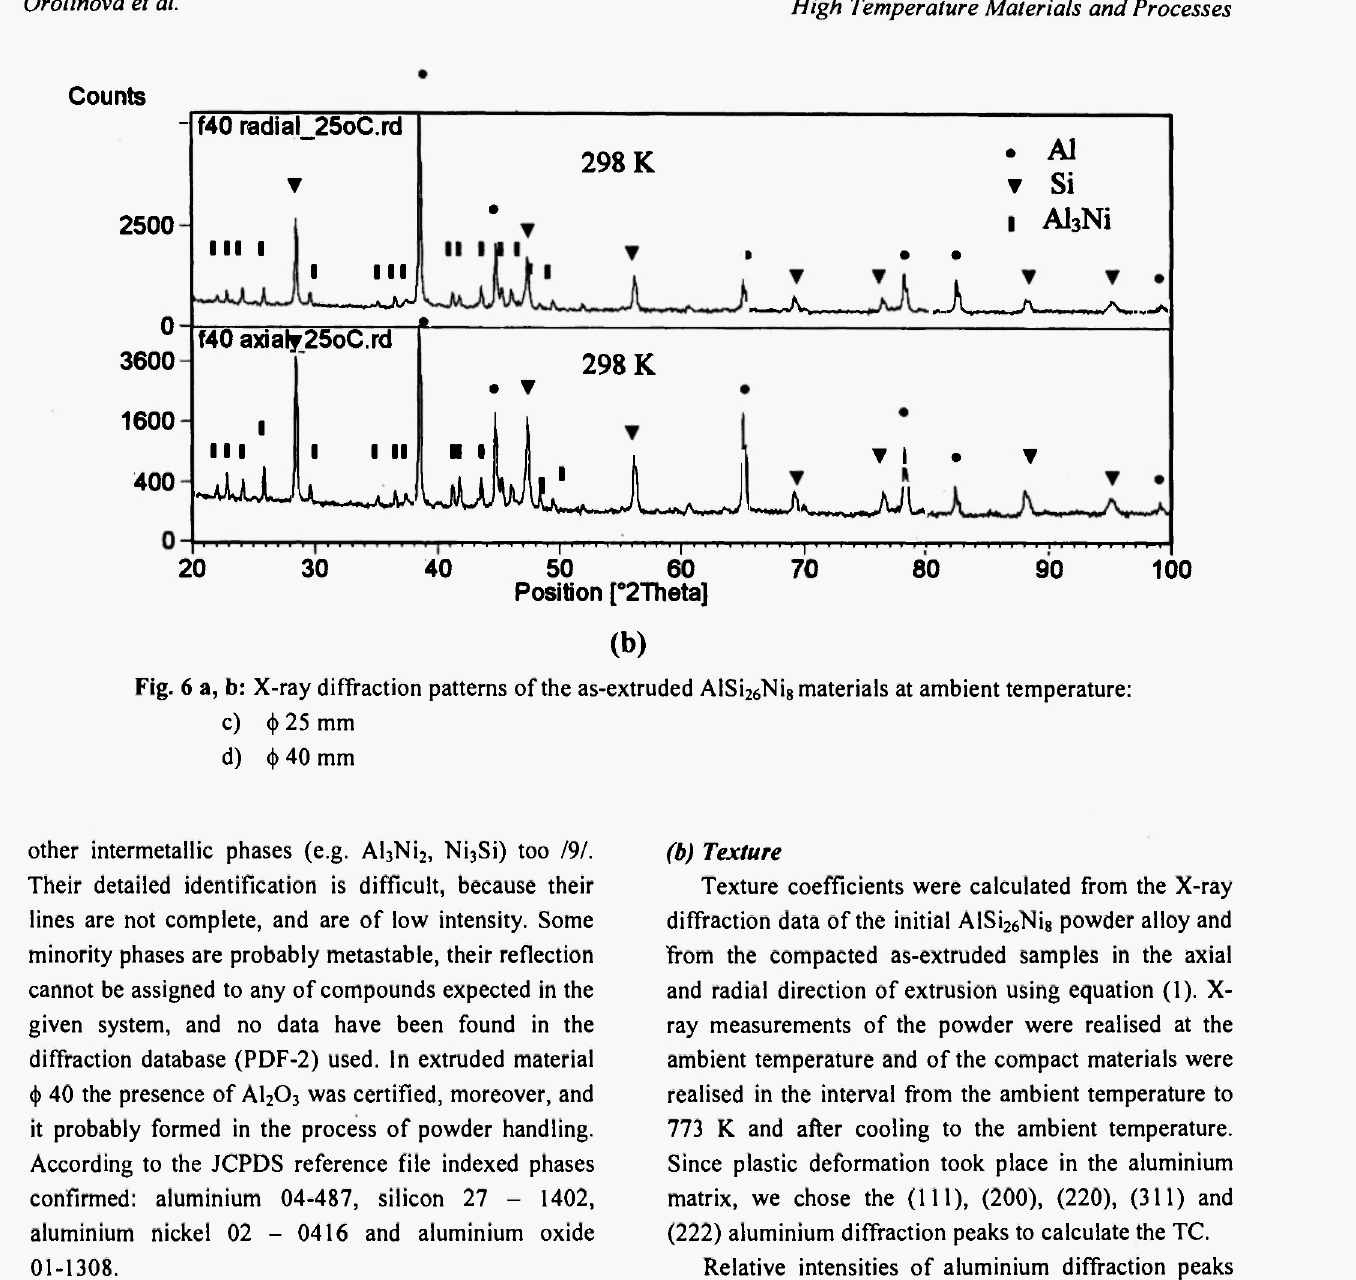
material are close to one. This indicated that the rapidly solidified experimental powder is in random